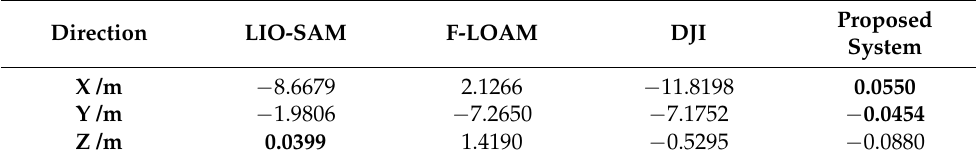
Table 2. Landing point error comparison.